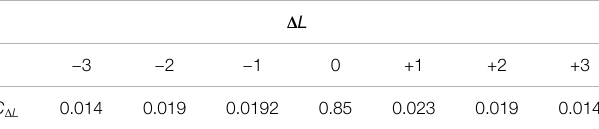
TABLE 1 | Coef fi cients of spiral spectrum modes for single Gaussion vortex